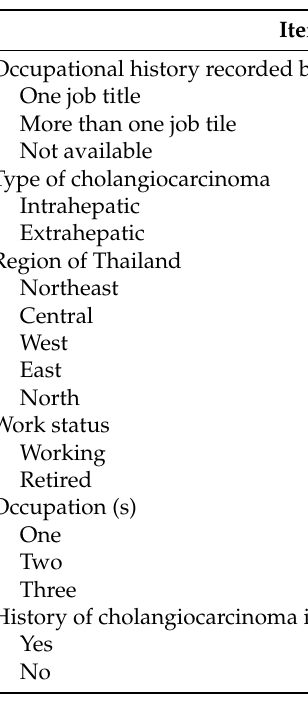
Table 2. Data obtained from medical record and telephone interview ( n =